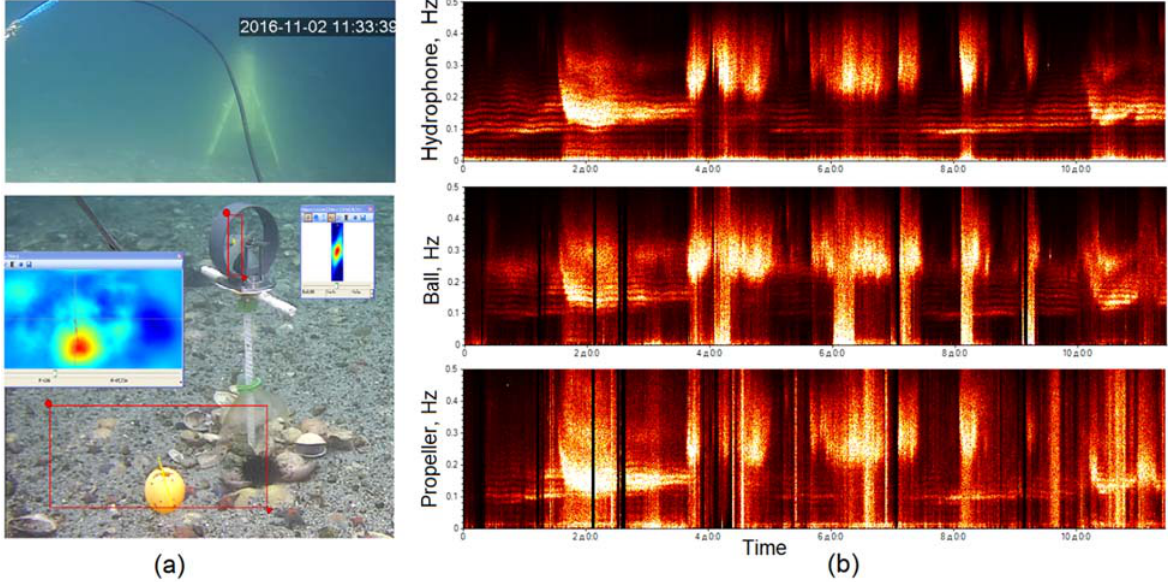
Figure 19. Underwater observations in Vityaz Bay on 15–27 November 2016: ( a ) laser hydrophone and measuring markers Ball and Propeller on the bottom of the bay; ( b ) spectrograms of Hydrophone, Ball and Propeller